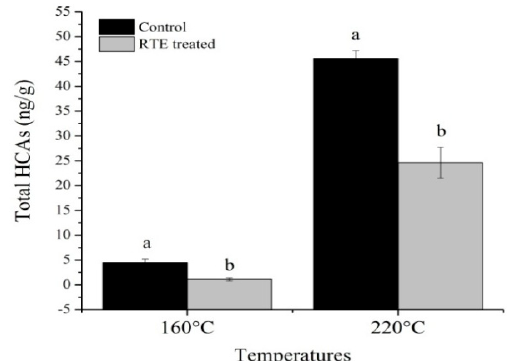
Figure 7. Effects of the Rosa rugosa tea extract (RTE) on the total HCAs; means ± SD of triplicate analyses; means bearing different letters (a, b) between control and RTE treated groups of single temperature indicate significant difference ( p < 0.05).